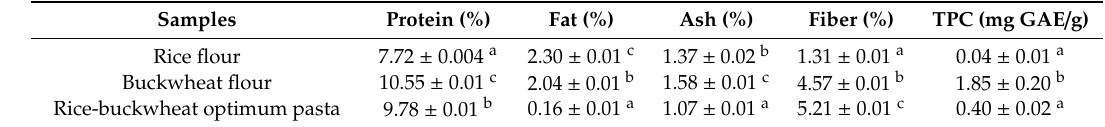
Table 4. Chemical composition (d.w.) of flours and gluten-free optimum pasta.